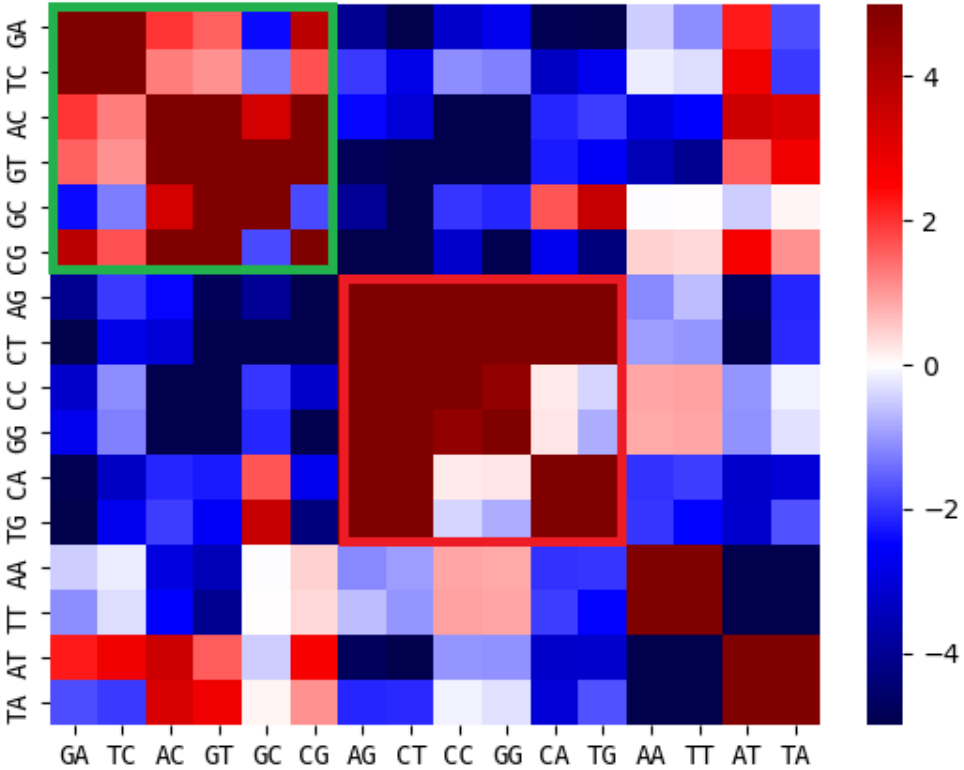
Figure 4. Significance levels of dinucleotide correlations sorted by CDS classes: significance levels of correlations between dinucleotide contents in relation to Chargaff model, sorted by the classes identified using correlations with chromosome length, gene content and CDS content. Correlations within classes are highlighted (green: correlated with genes, CDS anti-correlated with length; red: anti-correlated with genes, CDS correlated with length).